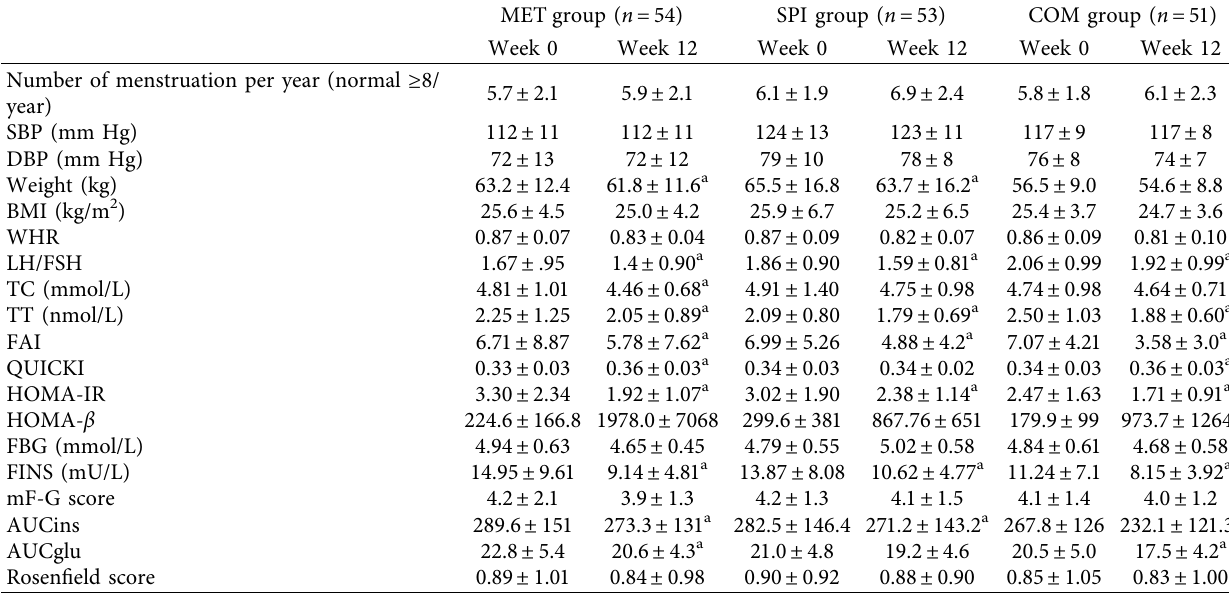
Table 2: Comparison of the three groups before and after